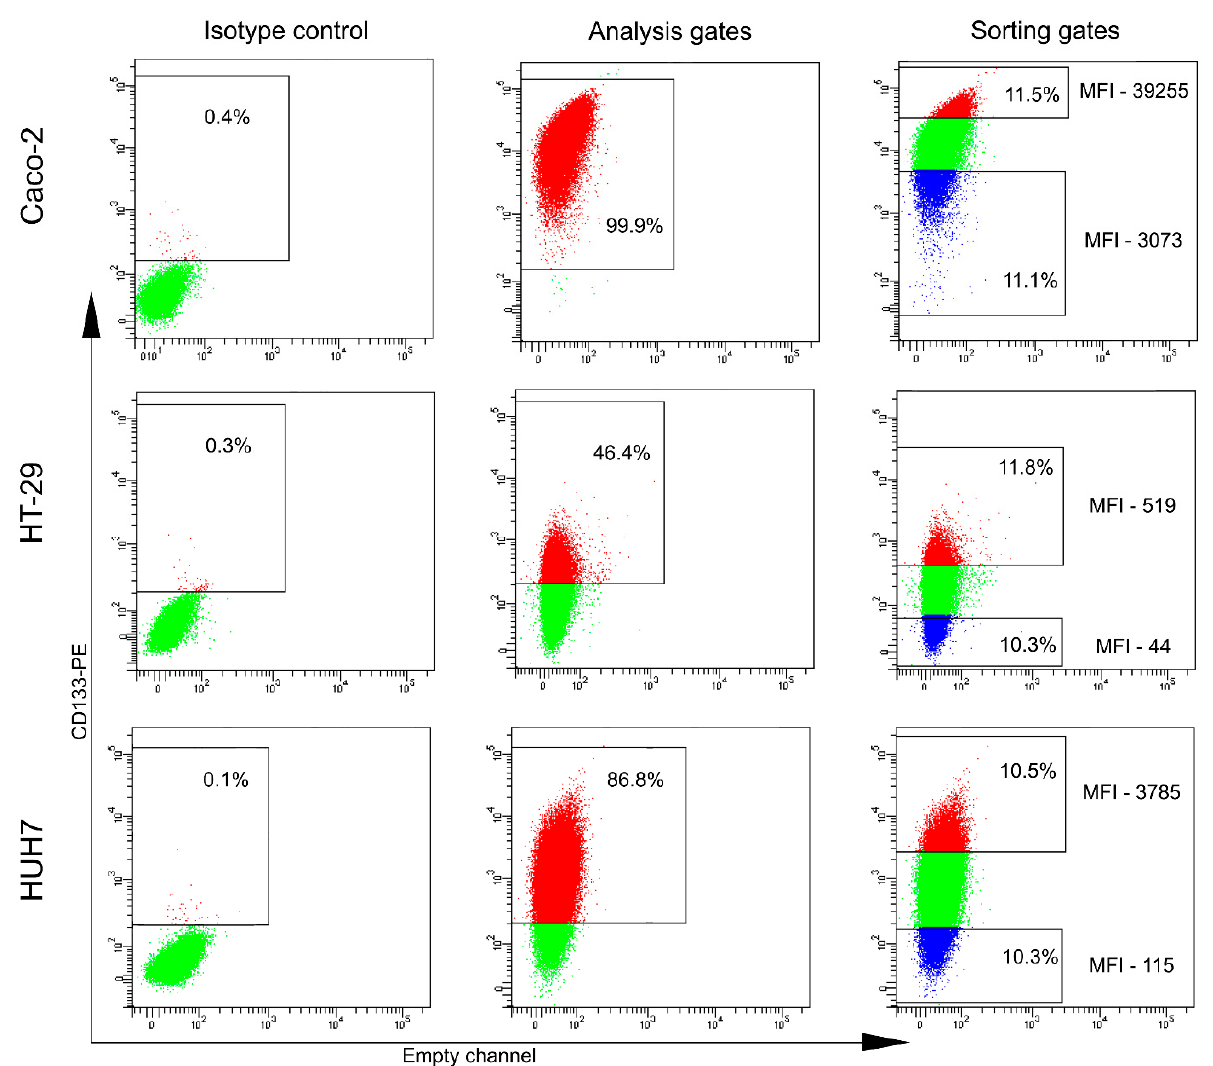
Figure 1. FACS analysis of CD133 expression in cancer cell lines and gating for CD133 +/high and CD133 − /low cells isolation. Left column panels: isotype controls. Middle column panels: CD133 staining of Caco2, HT-29, and HUH7 cells. FACS analysis gates were set up in accordance with the isotype controls. Right column panel: sorting gates of CD133 +/high (red dots) and CD133 − /low (blue dots) populations were set up to obtain no less than 10-fold difference between their median fluorescence intensities (MFI).